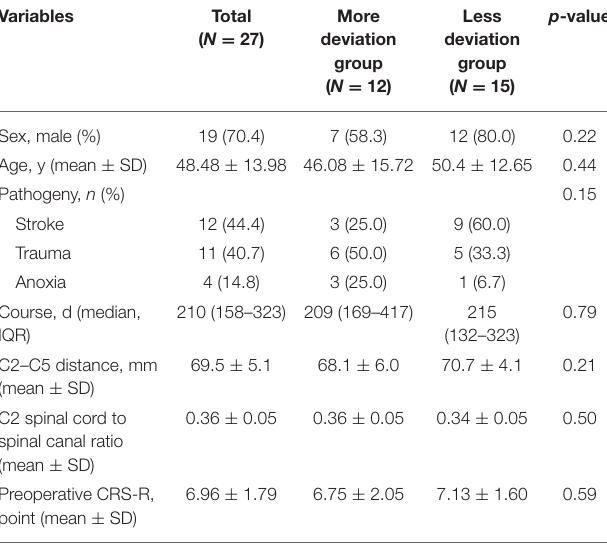
TABLE 1 | Preoperative factors on SCS electrode deviation. Variables